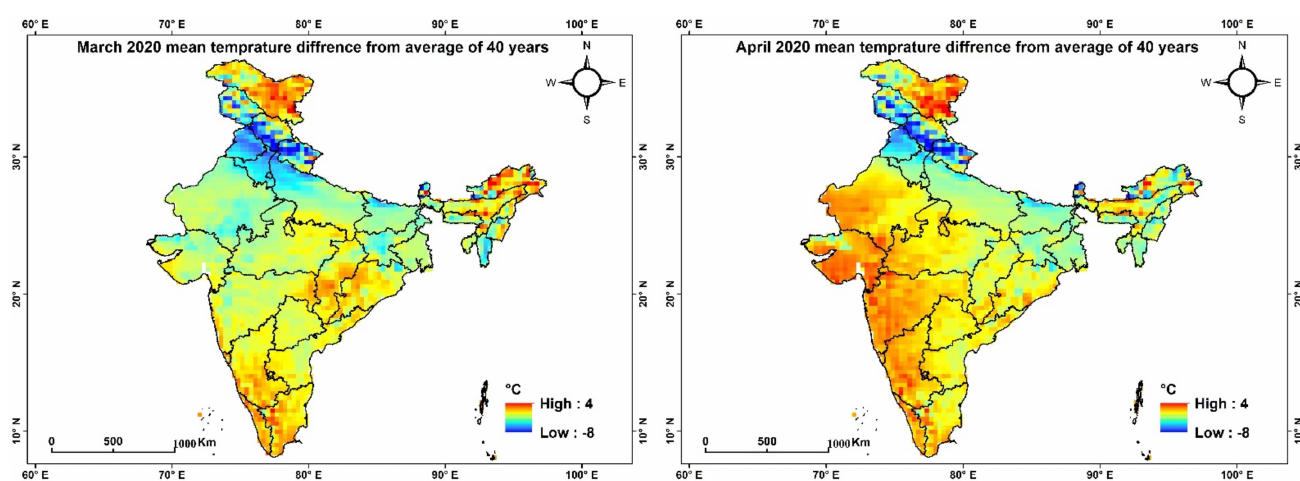
Figure 5. Ground-based NO 2 emission comparison over Amritsar, Bhatinda, Ludhiana Jalandhar, Khanna, Patiala, Delhi–Anand Vihar, Gurugram, Ghaziabad and Noida for the period of 2019 to 2021 (source: CPCB).